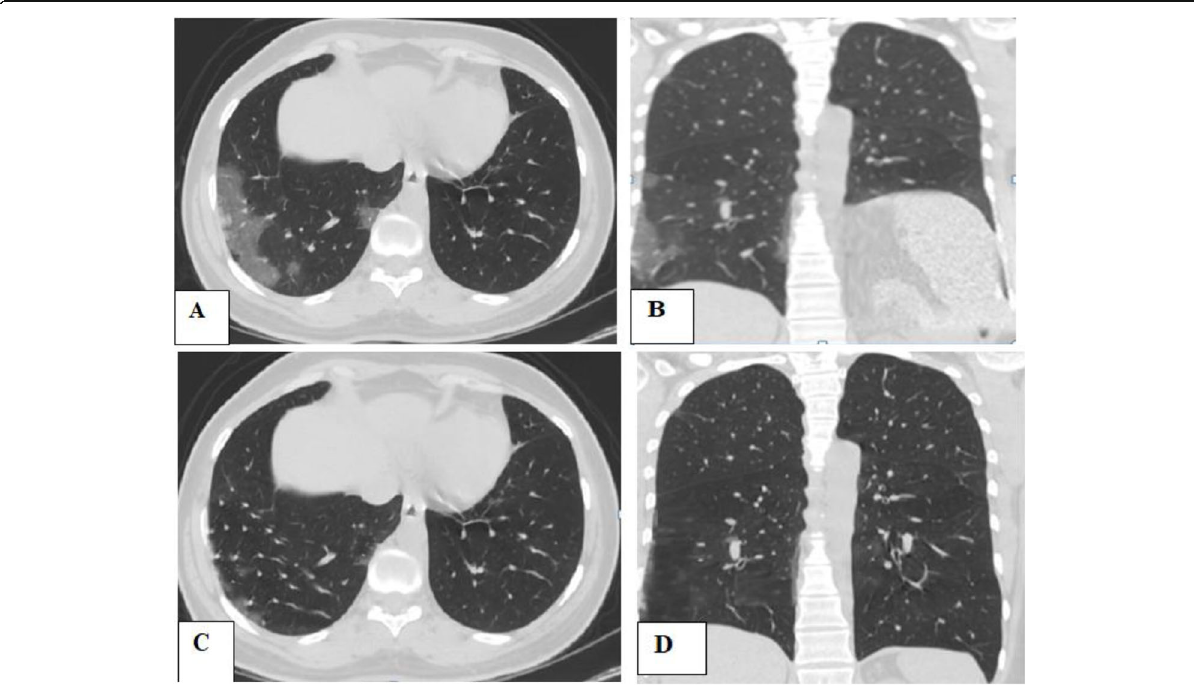
Fig. 3 Seventy-eight-year-old male patient, with a history of COVID-19 pneumonia, referred for initial CT evaluation with CT severity score 7. A , B Axial and coronal CT chest imaging respectively showed right sub-pleural ground-glass patches and pulmonary consolidation with interlobar septal thickening. Incidental discovery of left-sided diaphragmatic paralysis. C , D Images after 4 weeks reveals remarkable regression of the right- sided patchy ground glassing and consolidation with resolution of the previous left phrenic